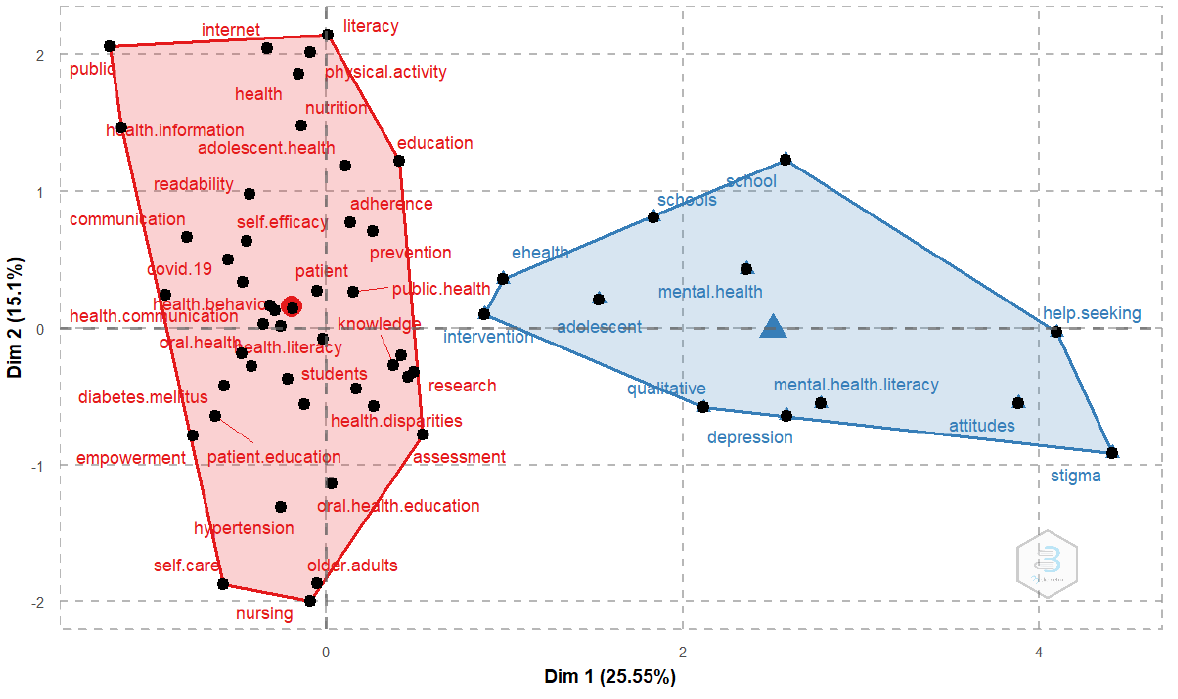
Figure 11. Conceptual structure map of authors’ keywords from the multiple correspondence anal- ysis.